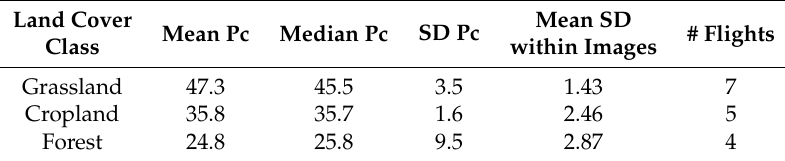
Table 2. Difference of Pc and standard deviation (SD) between land cover